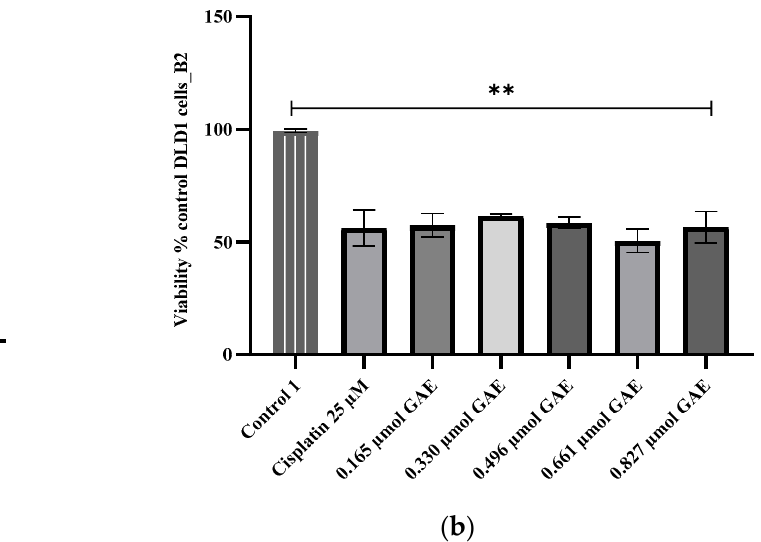
( b ) Figure 2. Viability percentages obtained for ( a ) BJ and ( b ) DLD-1 cells after 24 h incubation with A2 extract. The A2 concentrations were calculated according to the TPC µmol GAE (0.137–0.687 µmol GAE). Control 1 (negative control)—untreated cells; control 2—cells treated with cisplatin (25 µM). Data represent the mean ± SD of three independent experiments; ns—no significant differences; **— p < 0.05. This pattern of cytotoxicity was also noticed for the A2 extract, but only for its con- centrations ranging between 0.137 and 0.412 µmol GAE, while concentrations of 0.550 and 0.687 µmol GAE (IC 50 = 0.40 µmol GAE) exhibited cytotoxic effects similar to those of